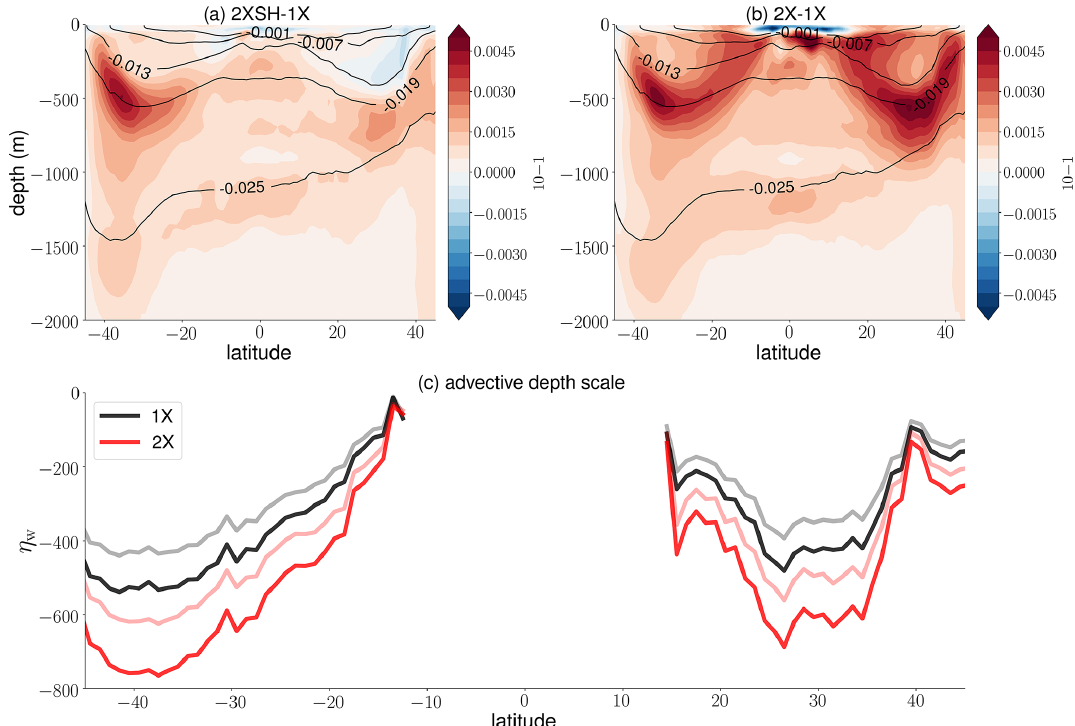
Figure 3. Differences in the zonal-mean density stratification averaged over the years 1991–2010: (a) the difference between the 2XSH and 1X experiments, and (b) the difference between the 2X and 1X experiments. The black contour lines represent the zonal-mean density strat- ification (10 − 1 ) in the 1X reference experiment. Density stratification is computed by ρ 0 Panel (c) shows the advective depth scale η w (in meters) in the 1X experiment (black) and the 2X experiment (red), with the reduced gravity set to g (cid:48) = 0 . 013 (opaque) and g (cid:48) = 0 . 02ms − 2 (transparent). The smaller the value for the reduced gravity, the deeper the advective depth scale η w